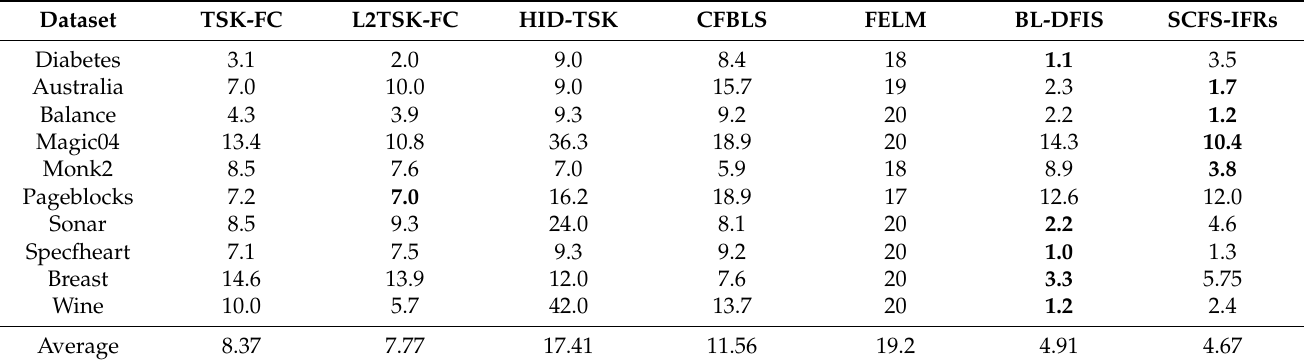
Table 9. Comparisons of average number of fuzzy rules on 10 datasets.